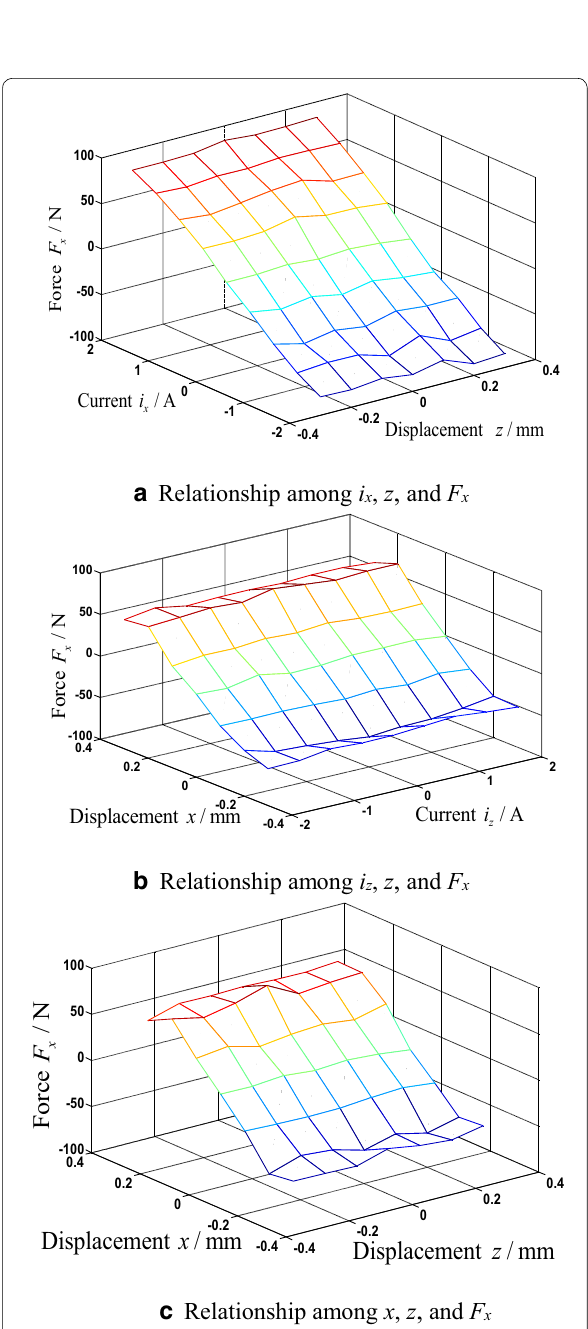
Figure 8 Relationship among forces, currents, and